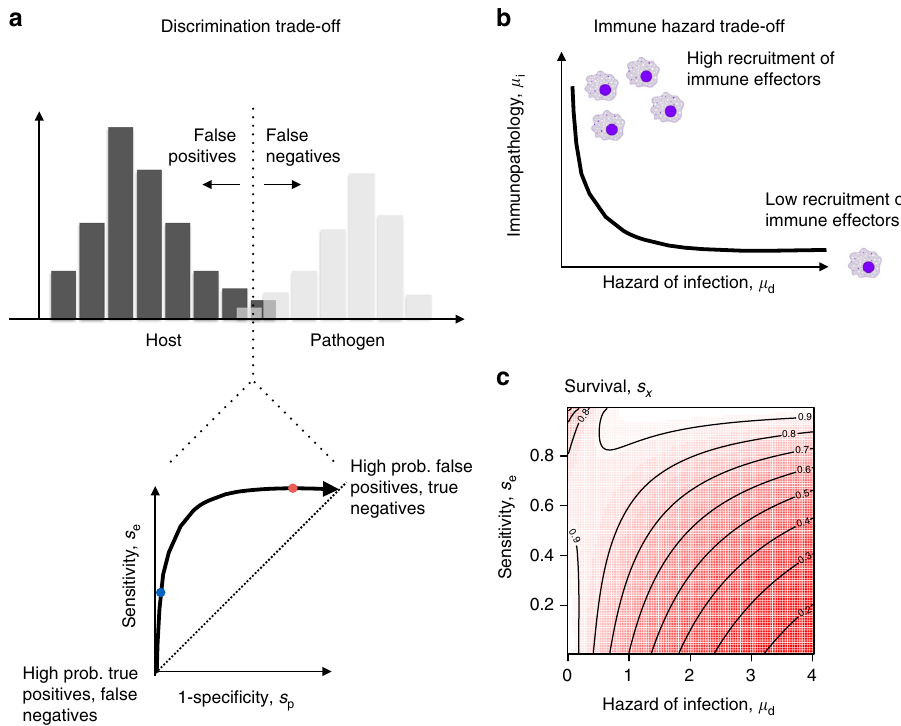
Fig. 1 Trade-offs underpinning differences in immune function. a Detection and discrimination: Selective pressure on pathogens to mimic host molecules to evade detection will result in overlap between the distribution of host (black histogram) and pathogen (gray histogram) molecules, which the immune system must discriminate. Host immunity then faces a trade-off between reducing false positives (triggering a response in the absence of pathogens) and reducing false negatives (failing to detect pathogens), as delineated by a classic Receiver Operator Curve (ROC) from epidemiology obtained by plotting sensitivity (proportion of true positives detected) against 1-speci fi city (proportion of true negatives detected). b Magnitude of immune response: a high magnitude response risks considerable damage associated with immunopathology, and thus an associated hazard of mortality ( μ i , y axis), but may more effectively control the pathogen, thus reducing the hazard of mortality associated with infection ( μ d , x axis), note that a variety of trade-off shapes are possible. c Optimizing survival: Combining these two trade-offs yields a bimodal landscape of survival, with high survival (lightest shades of red) corresponding to either low pathogen detection (low sensitivity, s e , y axis) and low risk of pathogen associated mortality ( μ d , x axis) corresponding to high levels of immune response and thus μ i (bottom left corner); or high pathogen detection (high sensitivity, y axis) and high risk of pathogen associated mortality ( μ d , x axis) resulting from a relatively small magnitude immune response (top right corner). To obtain the surface, we set: γ ¼ 4 ; η ¼ 0 : 8 ;